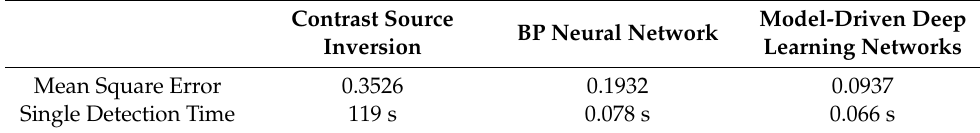
Table 4. Mean square error and average single detection time for each algorithm.